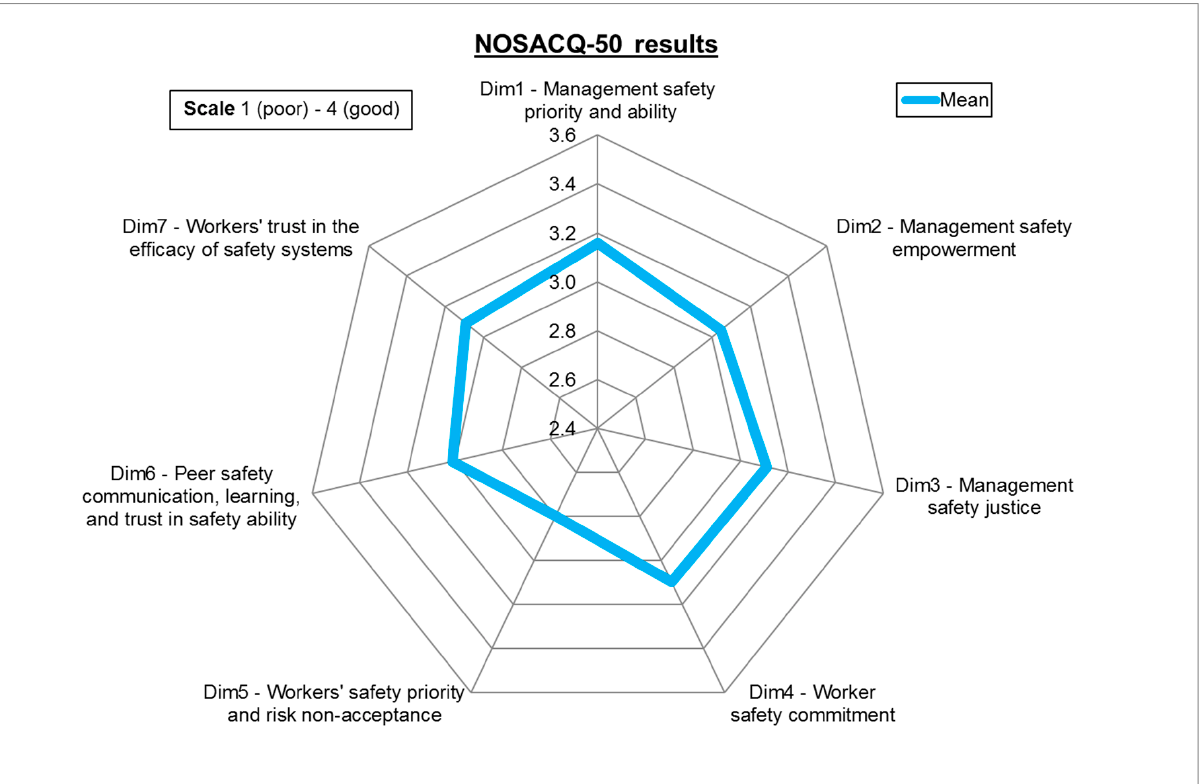
Figure 3. Overall results of the NOSACQ-50 questionnaire. Table 5. Scores of NOSACQ-50 divided per dimensions (expressed as mean values) and the related Cronbach’s Alpha